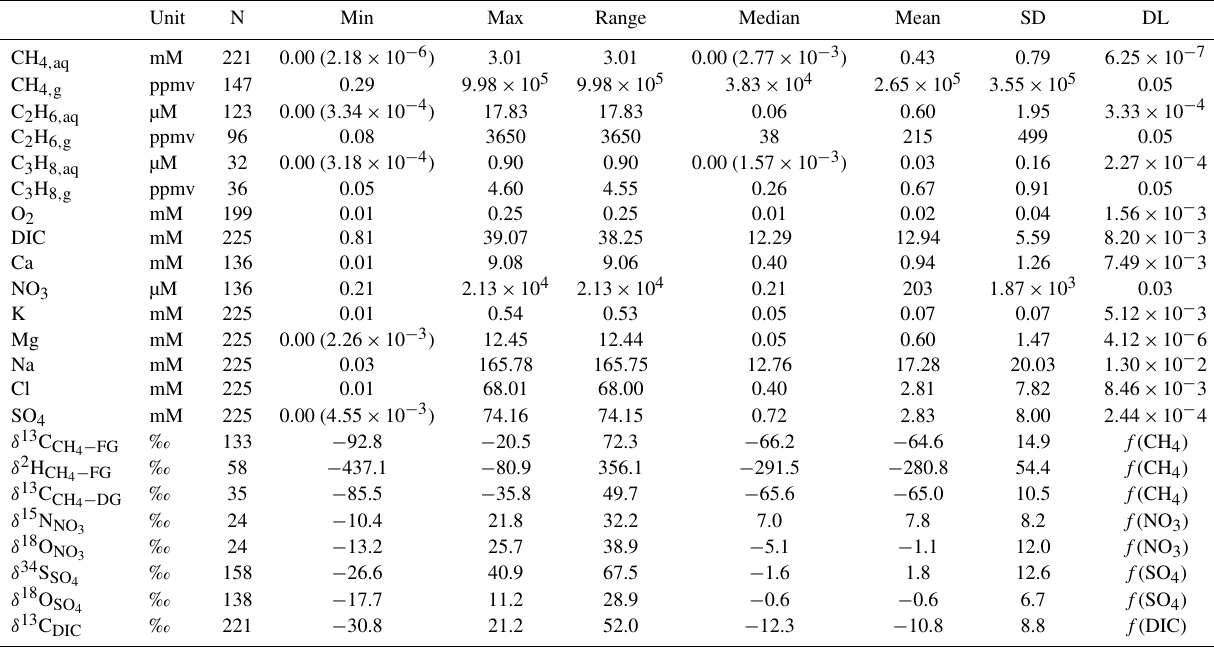
Table 2. Descriptive statistics for concentrations of major and minor species and for the isotopic composition of methane, nitrate, sulfate and DIC. Detection limits are also shown